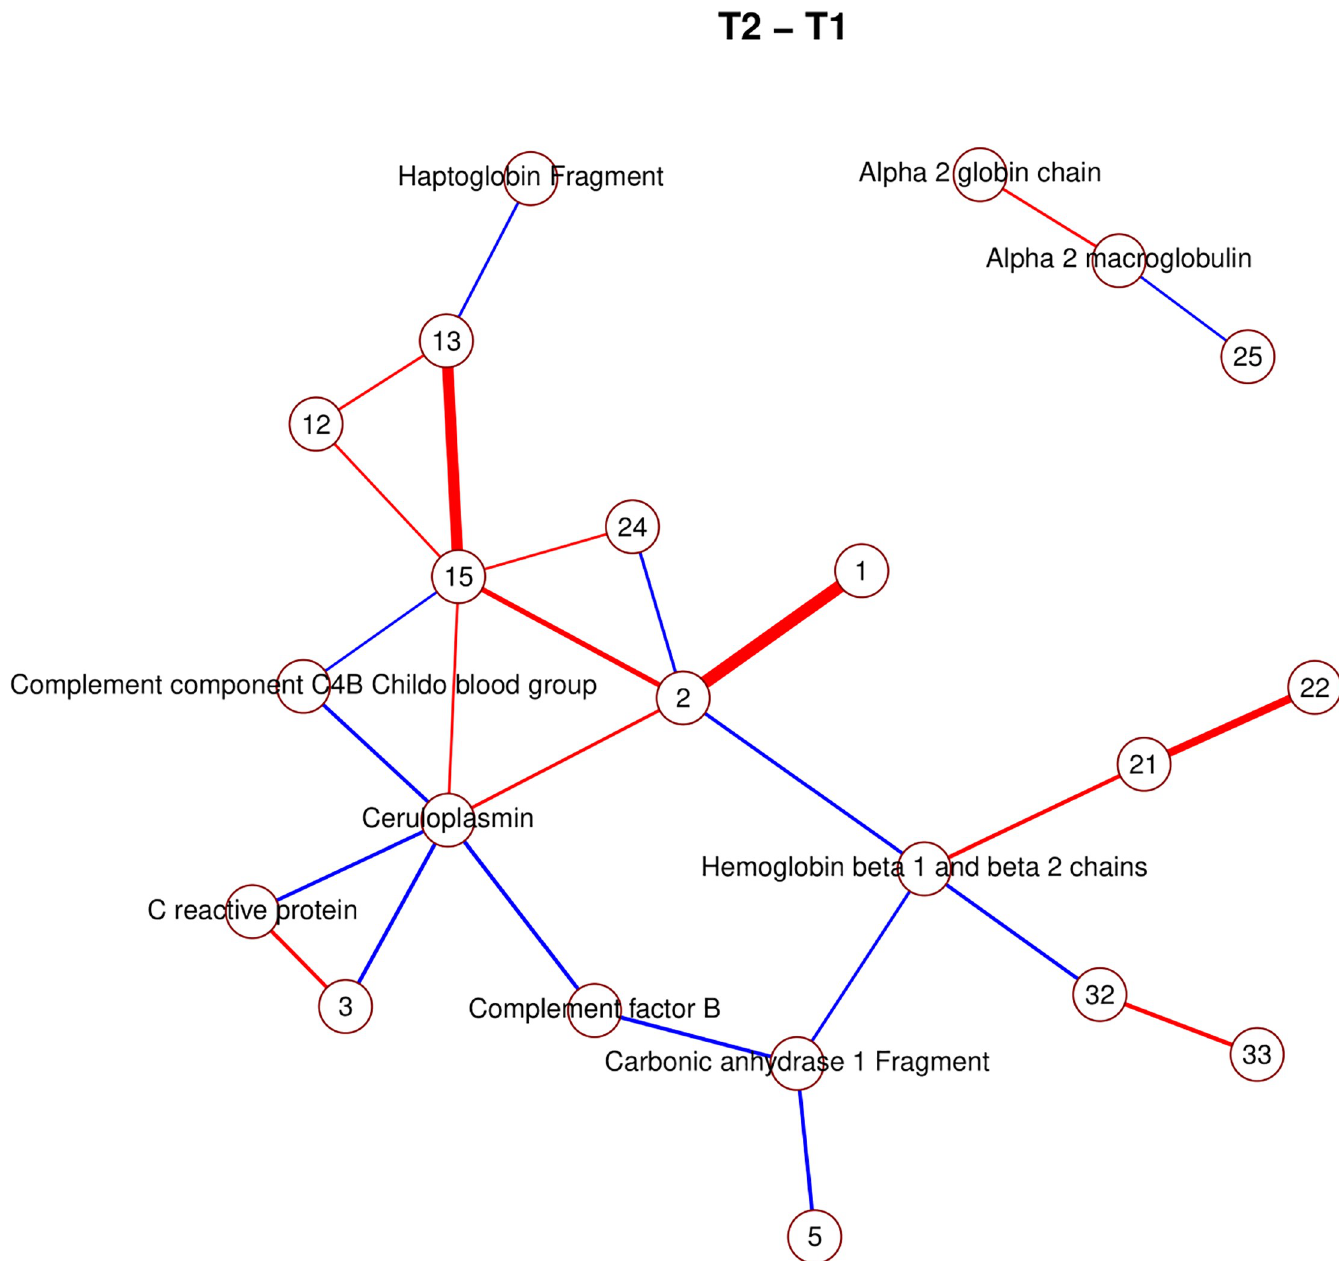
Fig 6. Non-zero partial correlations between differences in spot intensities from t 1 to t 2 displayed as a conditional independence network. Line width is proportional to the strength of the partial correlation and color represents positive (red) or negative (blue) partial correlation.